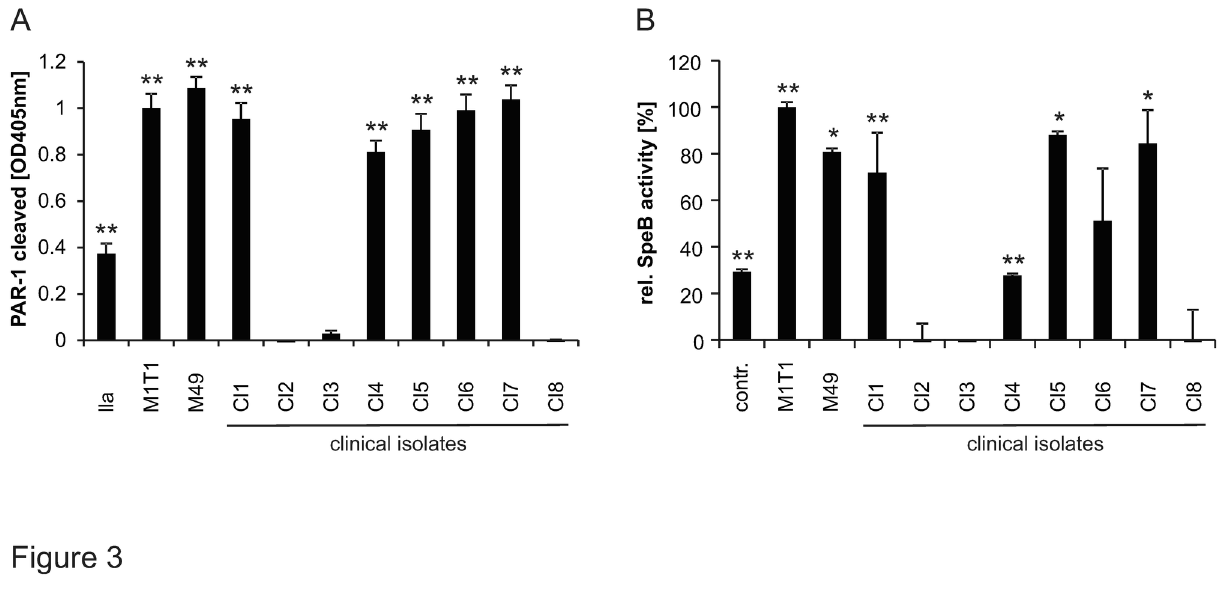
Figure 3. GAS strains cleaving PAR-1 expressed functional SpeB. ( A ) 293T cells transiently expressing alkaline phosphatase tagged PAR-1 were incubated with overnight supernatants of well characterized clinical GAS isolates M1T1, M49 and new clinical GAS isolates (Cl1-8). Then AP-PAR-1 cleavage was assessed. Thrombin (IIa; 1nM) served as positive control. ( B ) Samples from (A) were analysed for proteolytic SpeB activity by evaluating Bz-Pro-Phe-Arg-Nan cleavage. Experiments were repeated at least 3 times with N=9, data presented as mean+/-